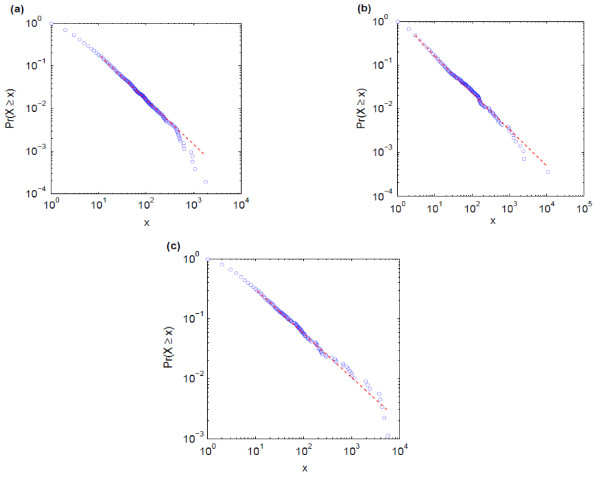
The cumulative distribution function Pr(x) plotted as a function of frequency (x) for GO gene annotations contained within Human GOA. The straight line shows the region of the plots for which a power law was found to provide a good model of the data [25]. 1(a) Annotation from the biological process sub-ontology, 1(b) annotation from the molecular function sub-ontology, and 1 (c) annotation from the cellular component sub-ontology The measured power law exponents, β, (were 2.04, 1.83, and 1.73 respectively. For all graphs p-value > 0.55, suggesting that the power law does provide a plausible model of the data.